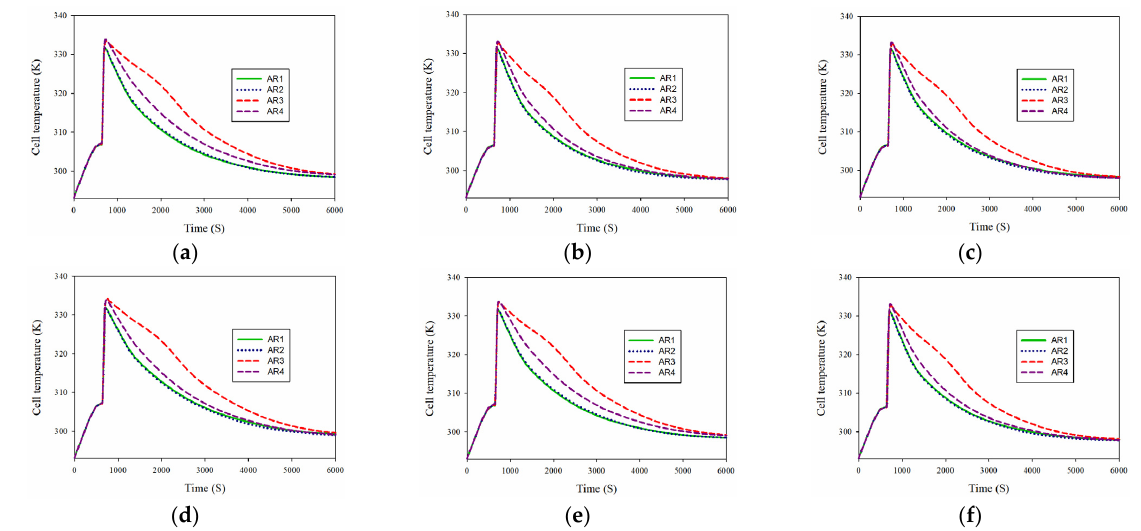
Figure 8. TOBs for different values of cavity AR up to 6000 s. ( a ) cell 1 ( b ) cell 2 ( c ) cell 3 ( d ) cell 4 ( e ) cell 5 ( f ) cell 6.